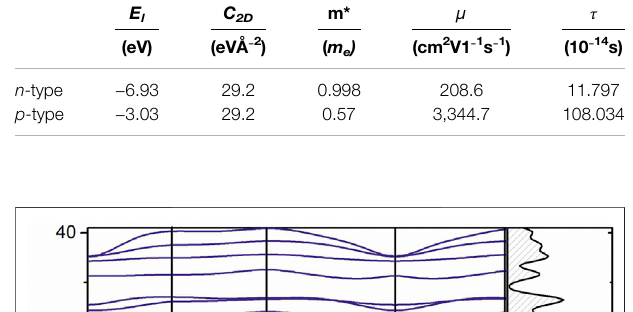
TABLE 1 | Calculated DP constant, elasticmodulus, carrier effective mass, carrier mobility, and carrier relaxation time at 300 K. E l